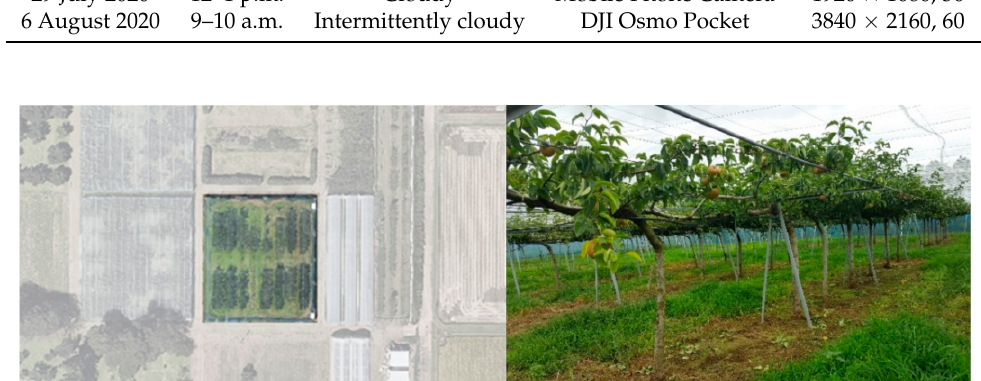
Figure 3. Aerial view of the joint-tree pear orchard ( left ). Joint-tree pear orchard in the Tsukuba-Plant Innovation Research Center, University of Tsukuba, Tsukuba, Ibaraki ( right